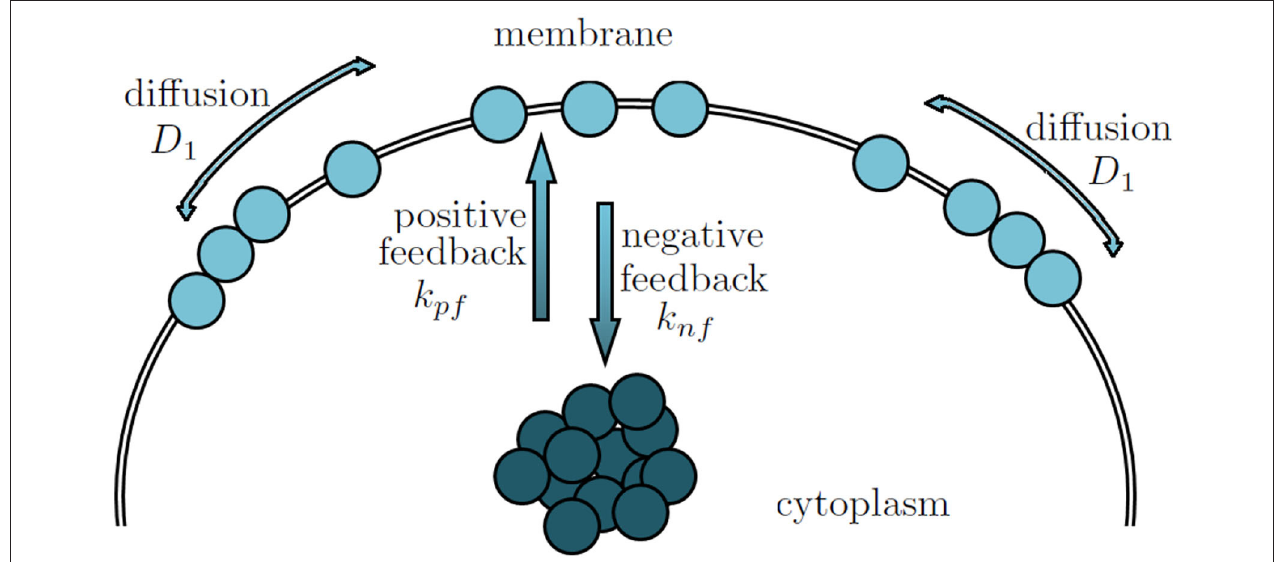
FIGURE 2 | The formation of ROP1 polarity is determined by the positive, negative feedbacks and the lateral diffusion.